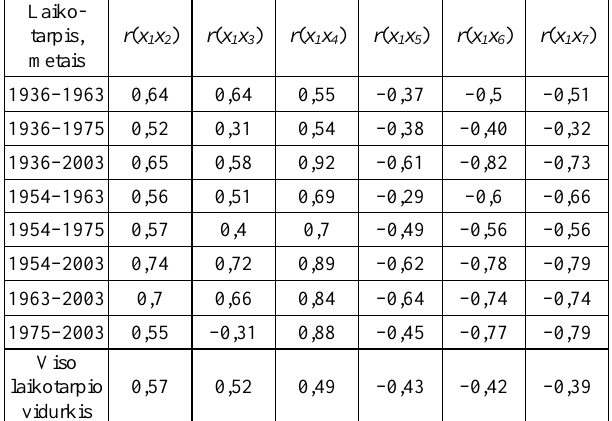
Table 1. The correlation of vertical Earth surface movement speed with geological, geomorphologic